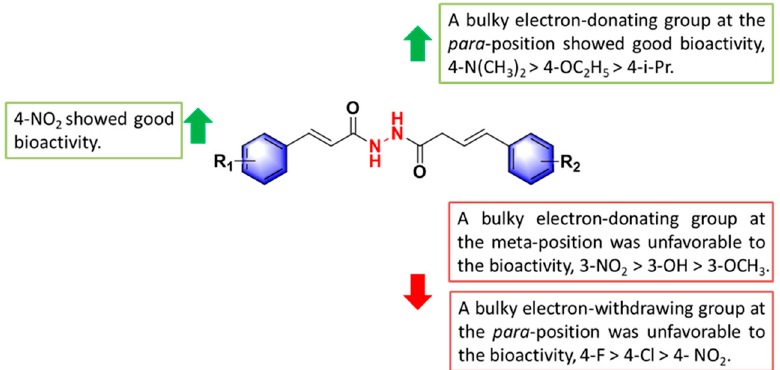
Figure 2. Description diagram of structure-activity relationship (SAR) analysis. To evaluate the selectivity of target compounds against cancer cell lines and normal cell lines, certain target compounds were evaluated by using the NRK-52E cell line. As Table